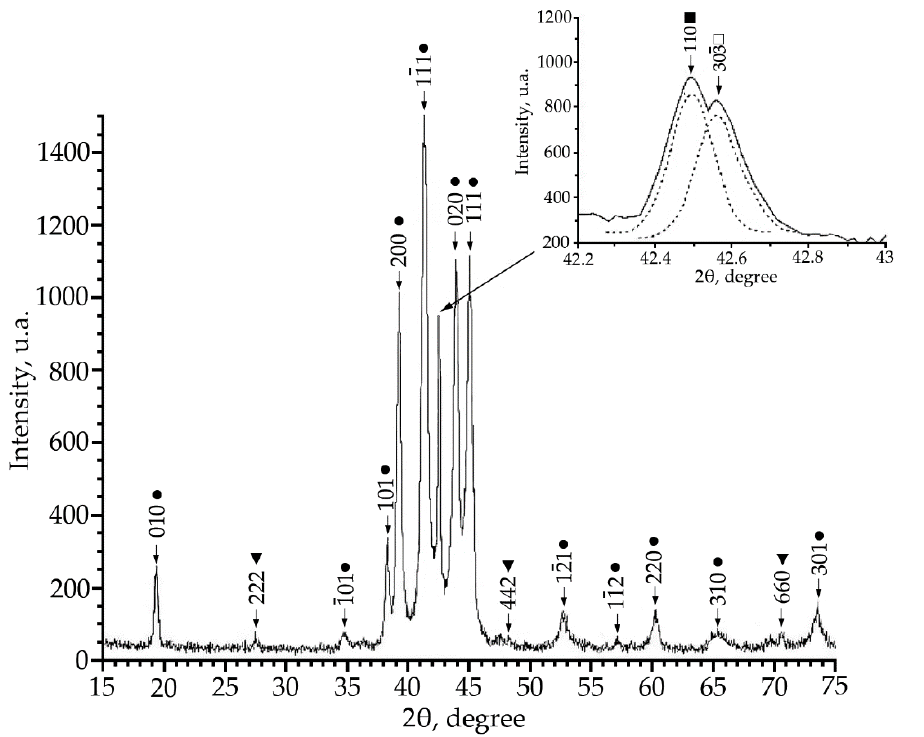
Figure 1. X-ray patterns ( Cu Kα radiation) from alloy No. 1, where: •—martensitic phase В19′ ; ■ — В2 -phase; ▼ — Ti 2 Ni secondary phase; — R-phase.